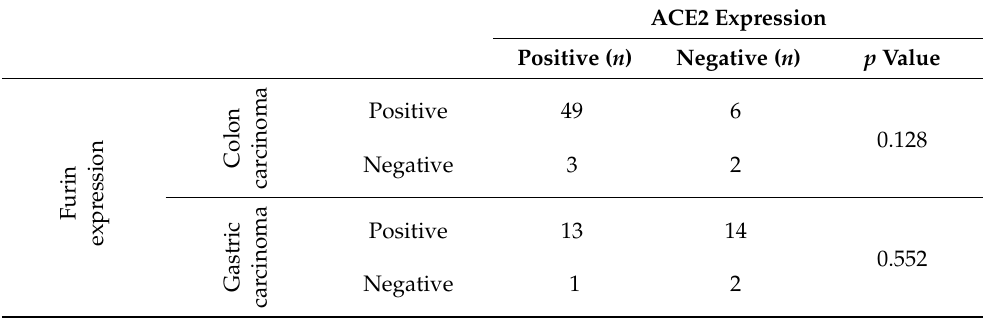
Table 1. Association between the expressions of ACE2 and furin in colon, gastric, and thyroid